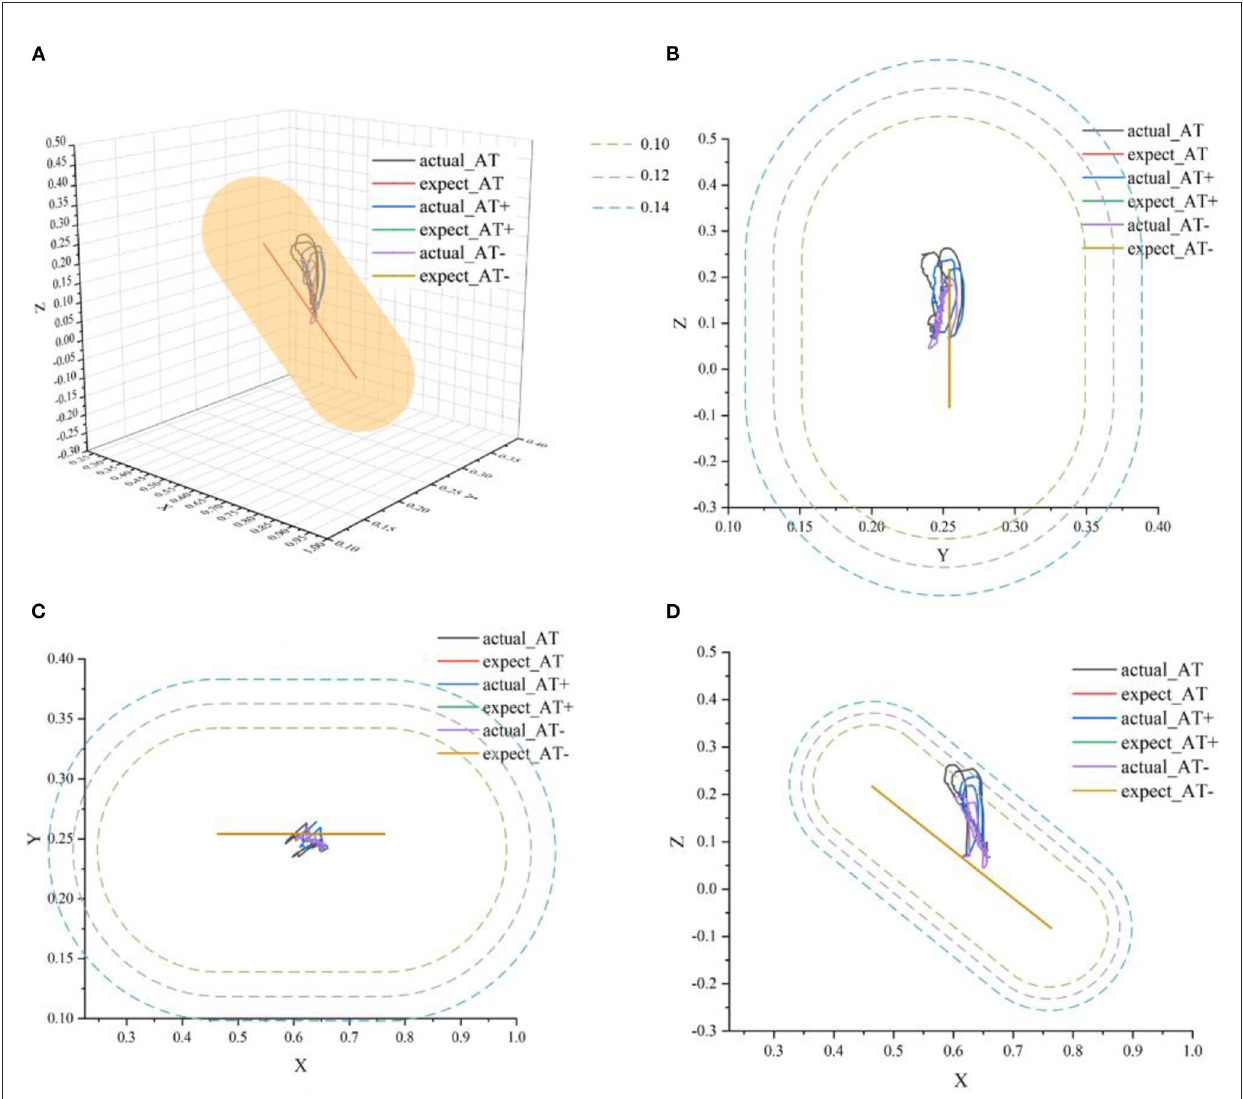
FIGURE12 The ideal movement trajectory and the actual training trajectory in the active training mode: (A) three-dimensional spatial view; (B) YOZ view; (C) XOY view; (D) XOZ view.